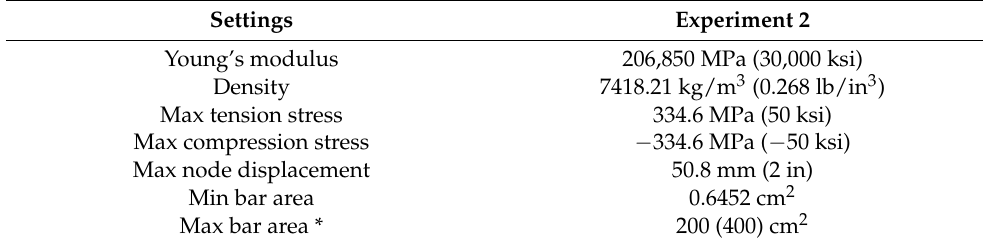
Table 5. Material properties and constraint parameter settings in experiment 2.